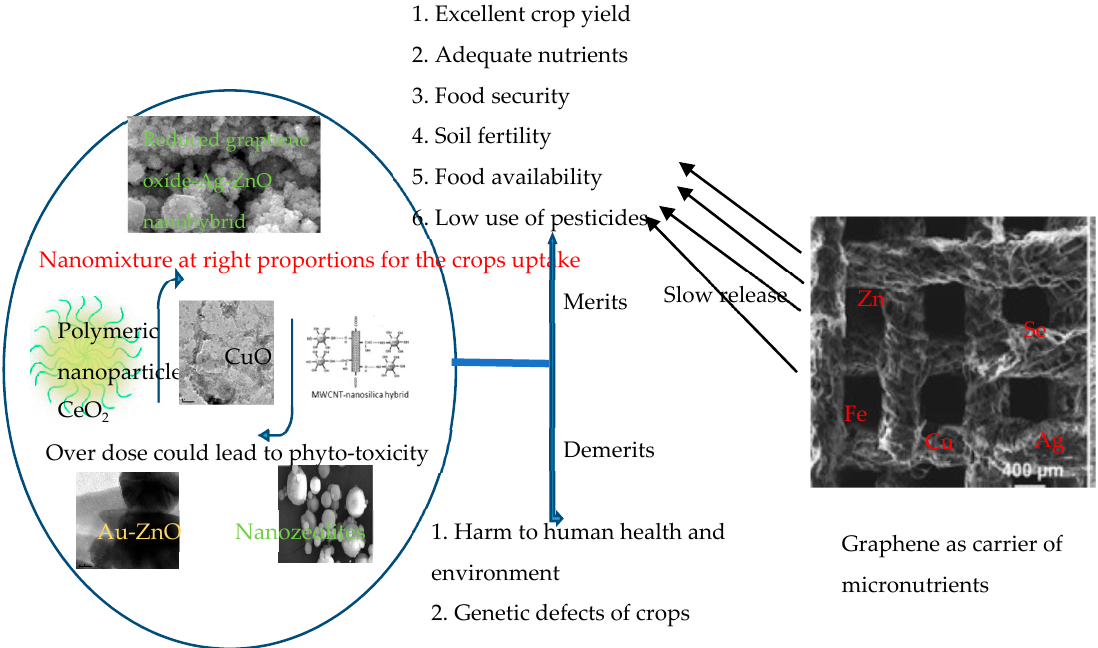
Figure 3. Improving the quality of soil and crops using appropriate nanoparticles [Adapted from 148- 151].